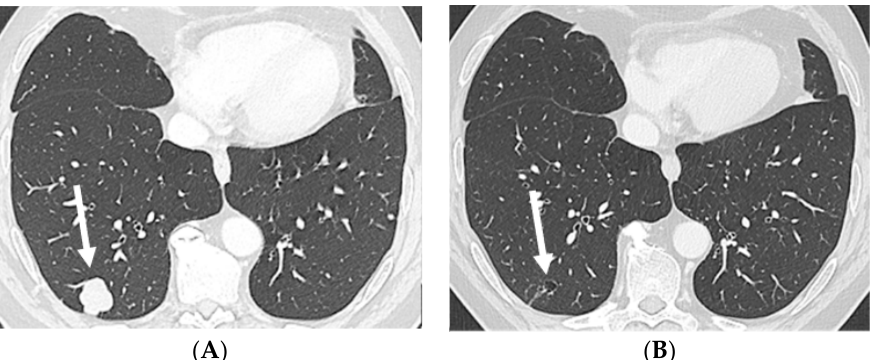
Figure 2. Axial CT in lung window: baseline, prior to EV treatment ( A ), and after three cycles of EV ( B ) shows a large solid metastasis in the subpleural region of the right lower lobe regressing into a small, excavated, and thin ‐ walled air ‐ containing cystic remnant after treatment (arrows). Abbrevi ‐ ations: CT, computed tomography; EV, enfortumab vedotin.